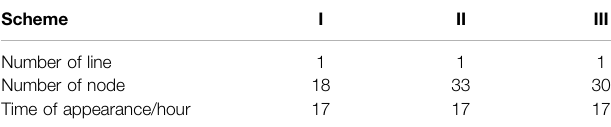
TABLE 3 | Worst case of lines and nodes on each scheme.